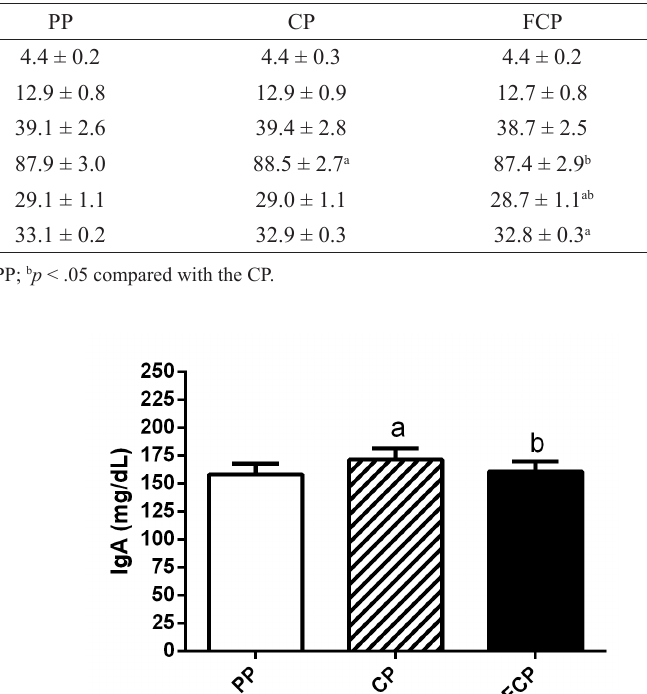
Table 5. Effect of selective loads periodization on erytrogram of female futsal players in the beginning of the preparatory (PP), competitive (CP) and final competitive period (FCP).